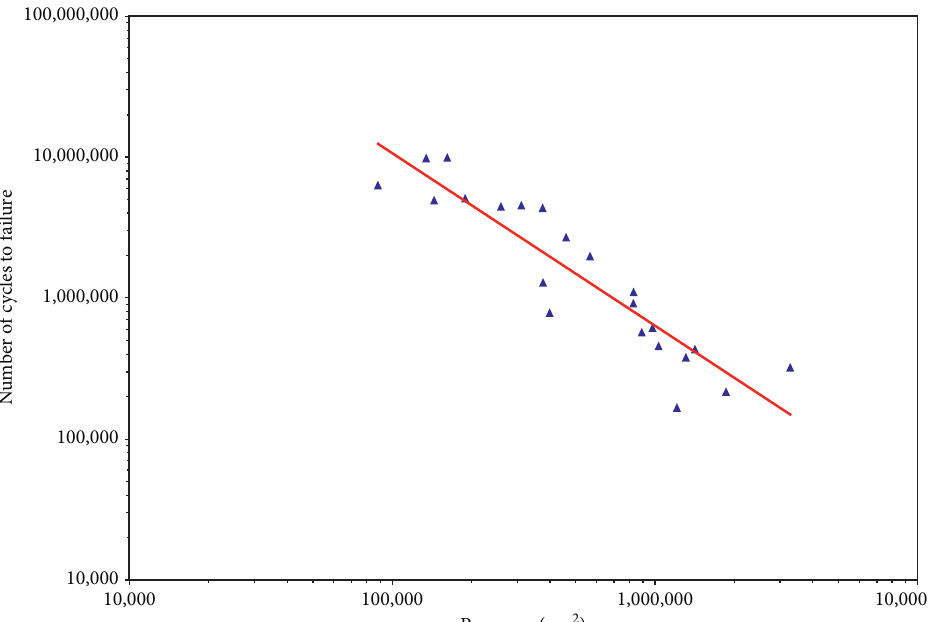
Figure 14: Effect of porosity volume fraction on the fatigue life of A356 alloy in the T6 condition [33].